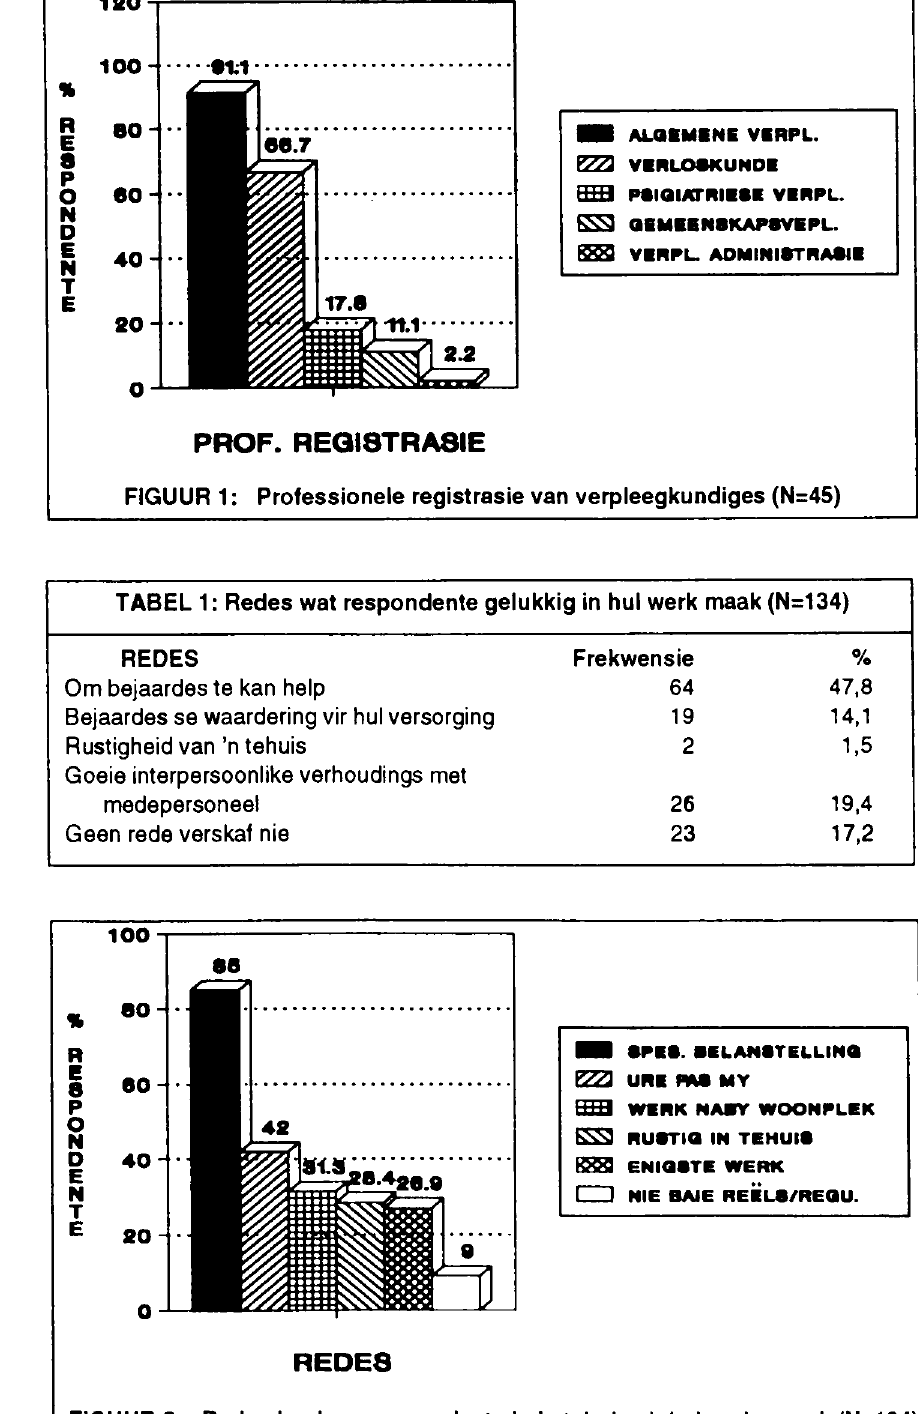
FIGUUR 2: Redes hoekom respondente in ’n tehuis vir bejaardes werk (N=134)